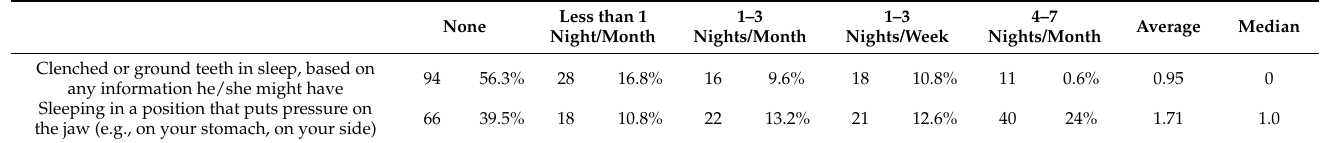
Table 6. Results for questions related to OBs during